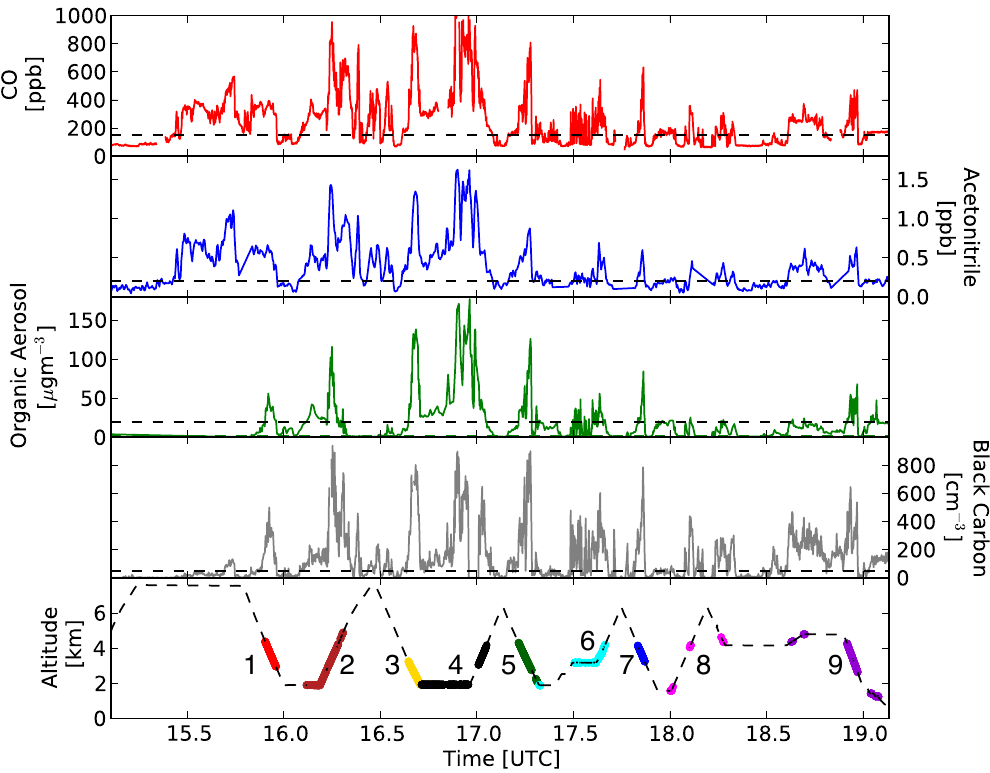
Figure 2. Time series of BORTAS-B aircraft measurements of biomass-burning tracer species for Flight b622. Threshold values (dashed black lines) were used across four species as plume criteria: (i) CO (red, threshold = 150ppb), (ii) acetonitrile (blue, threshold = 200pptv), (iii) organic aerosols (green, mass threshold = 20µgm − 3 , at STP ), (iv) black carbon (grey, number threshold = 50cm − 3 , at STP). The bottom panel shows flight altitude with plume sampling periods coloured. The plume data is further divided into transects (1–9 in